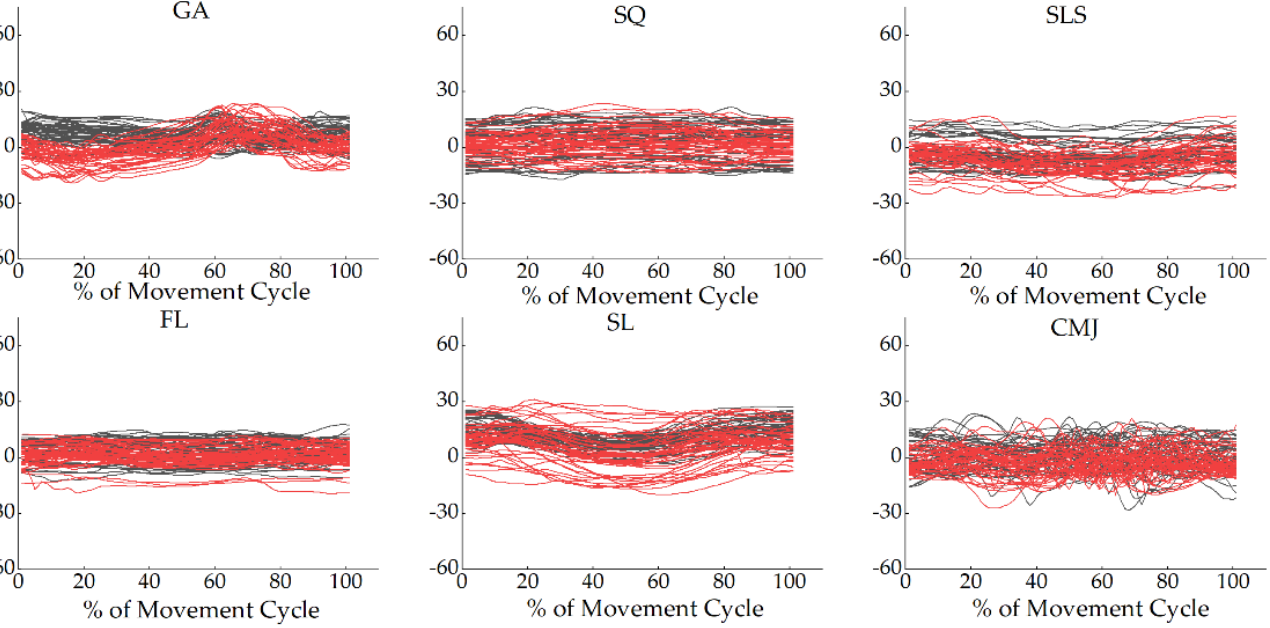
Figure A6. Ankle joint angles in the transverse plane for each participant in all tasks during the movement cycle of the gait (GA), squat (SQ), single-leg squat (SLS), side lunge (SL), forward lunge (FL), and counter-movement jump (CMJ). The black lines represent the OptiTrack system, while the red lines represent the Perception Neuron ® system. The Y -axis depicts joint angles in degrees, while the X -axis depicts the movement cycle in %.